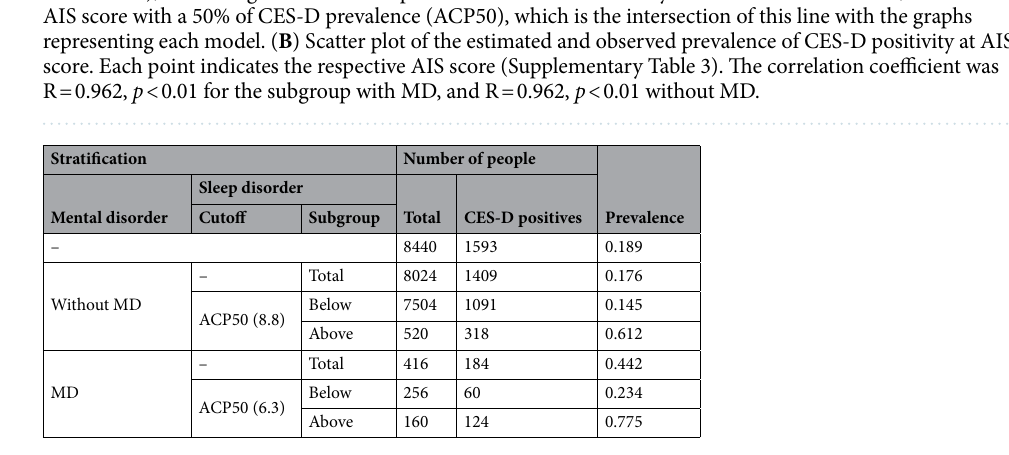
Table 1. Prevalence of Center for Epidemiologic Studies Depression positivity in each subgroup stratified by history of mental disorder and sleep disorders.